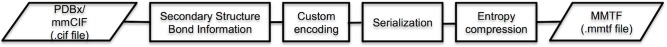
Steps in the creation of a MMTF file from a PDBx/mmCIF file.After parsing a PDBx/mmCIF file, DSSP secondary structure is calculated and bond information is added for all residues. Custom encoding strategies are applied to the different data categories to achieve a compact representation. These data are serialized in binary form and then further compressed with standard compression tools to create a compressed MMTF file.